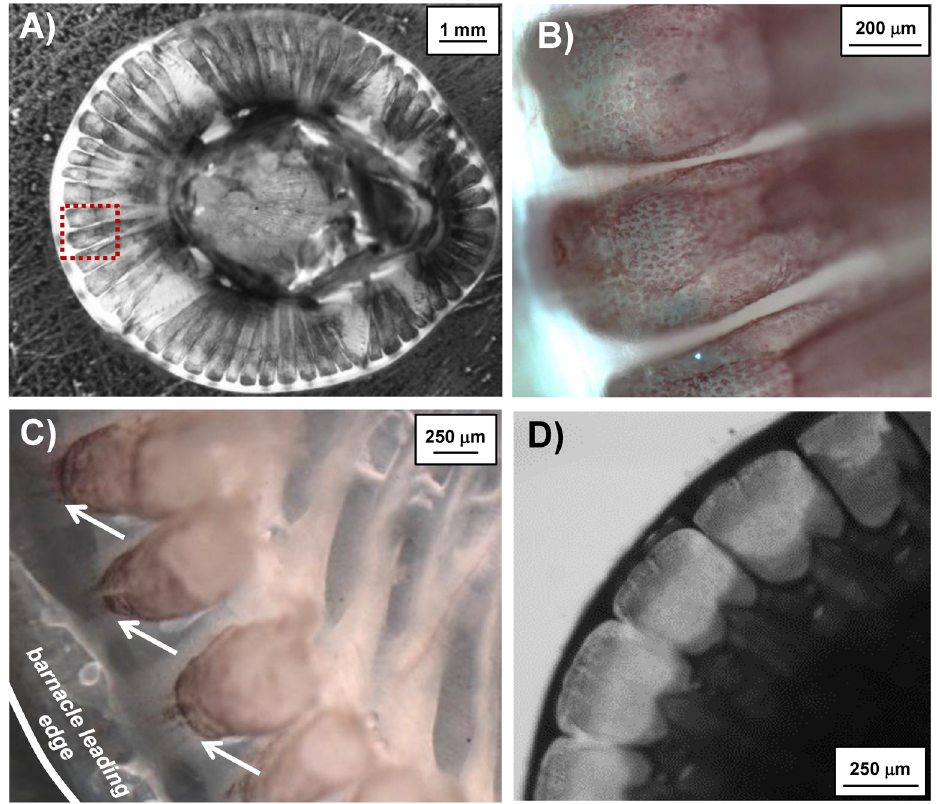
Fig 2. Brightfield images of partially demineralized A . amphitrite and exposed LCT. A) Top view of partially demineralized A . amphitrite with LCT exposed at the periphery. Dashed red box represents area under higher magnification in panel B), showing greater detail of the exposed LCT including the pink hue arising from the speckled epithelial layer. C) Image of exposed LCT showing their termination into channel-like projections toward the barnacle leading edge. D) Top-down view of partially demineralized A . amphitrite highlighting the longitudinal cavities containing the tissue of interest.